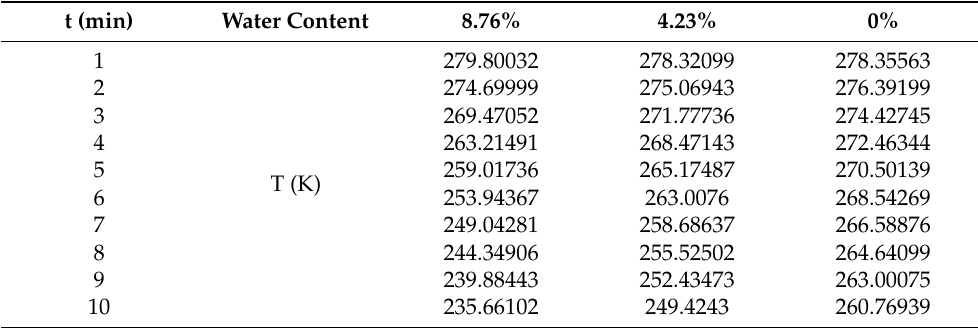
Table 1. Temperature variation law of the coal samples with a different water content from 4 ◦ C to − 10 ◦ C (60 mm).